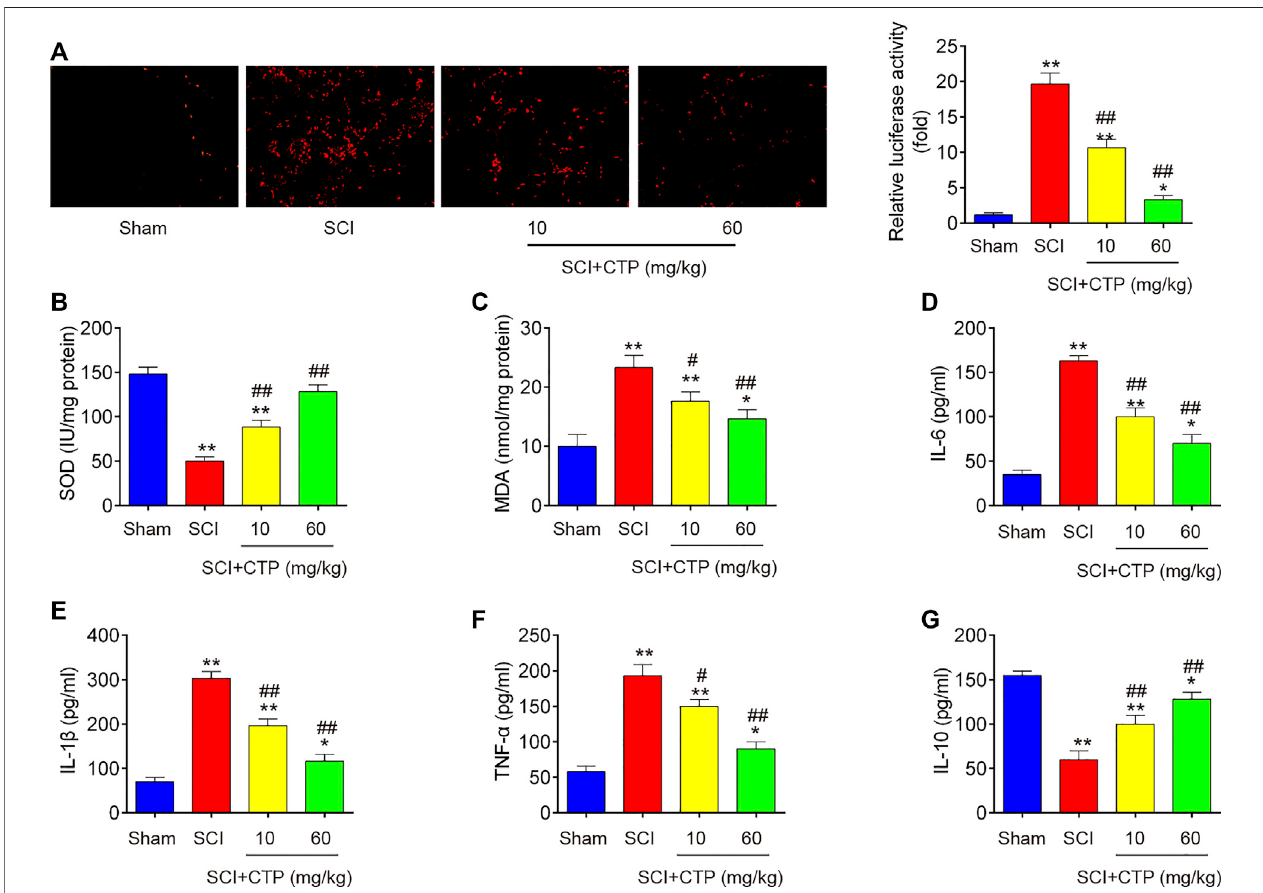
FIGURE 2 | Catalpol reduces oxidative stress and in fl ammation in spinal cord of SCI mice. After SCI mice model was established, CTP (10 and 60 mg/kg) was subjected to SCI mice once a day for 28 days. (A) ROS generation was calculated using 2,7-DCF-DA staining kit. (B and C) The contents of MDA and SOD were measuredbycommercialkits. (D – G) Thein fl ammatorycytokinesincludingTNF- α ,IL-1 β ,IL-6andIL-10,wereevaluatedbyELISAassays.Datarepresentthemean ± SD of three independent experiments. * p < 0.05, ** p < 0.01 vs. Sham group; # p < 0.05, ## p < 0.01 vs. SCI group.